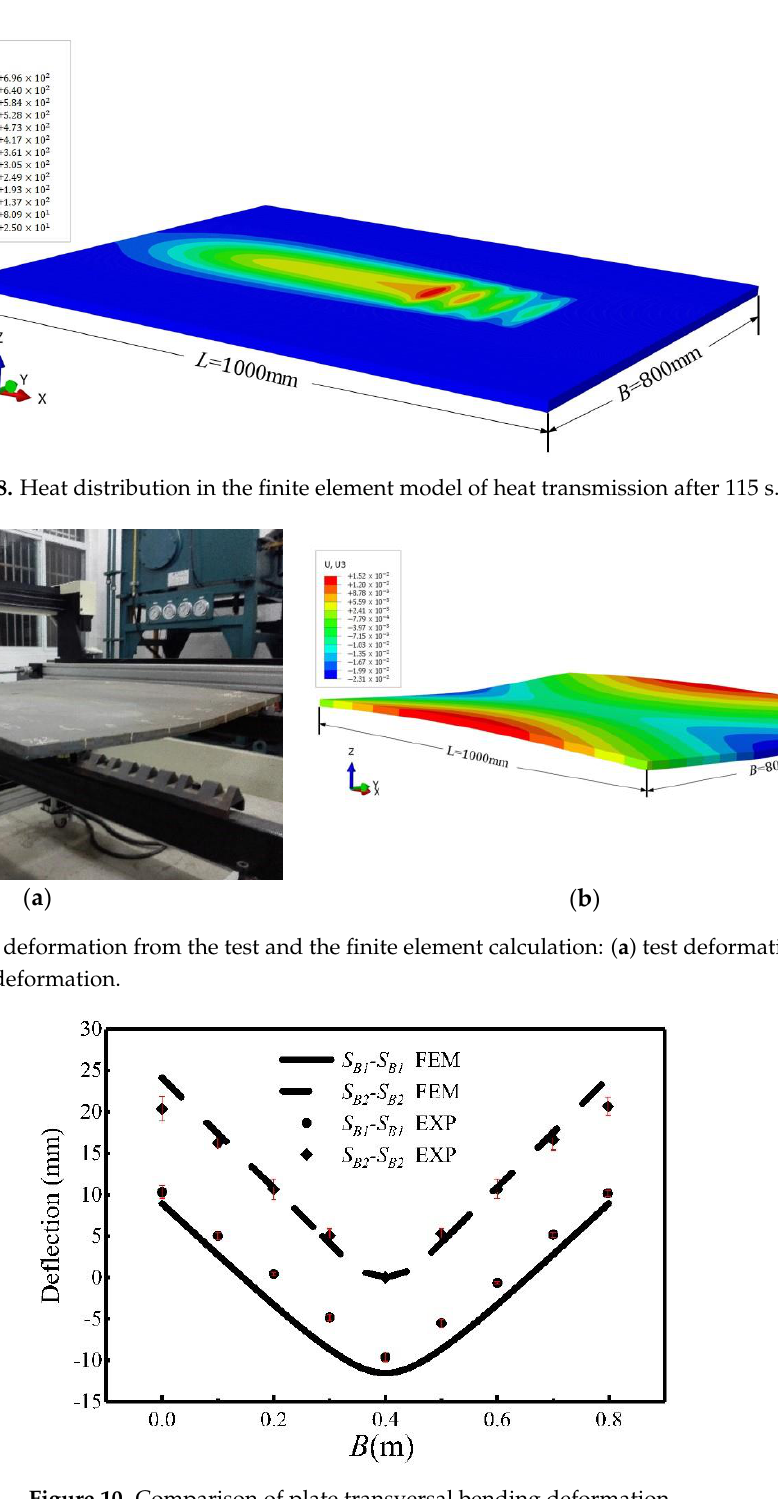
Figure 10. Comparison of plate transversal bending deformation.